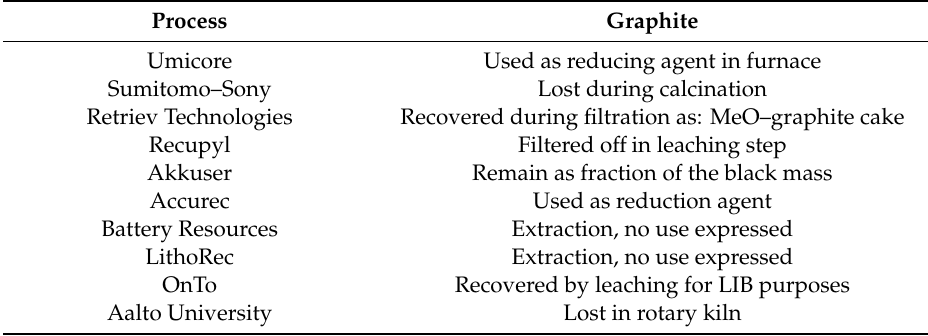
Table 6. Graphite recovery summary in emerging